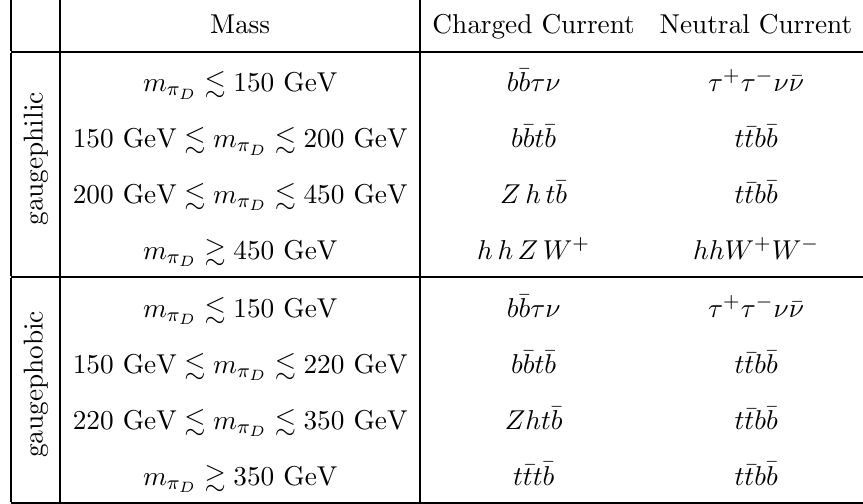
Table 2 . Phenomenological regions for collider signatures. The charged and neutral current columns show the SM particles for the dominant branching